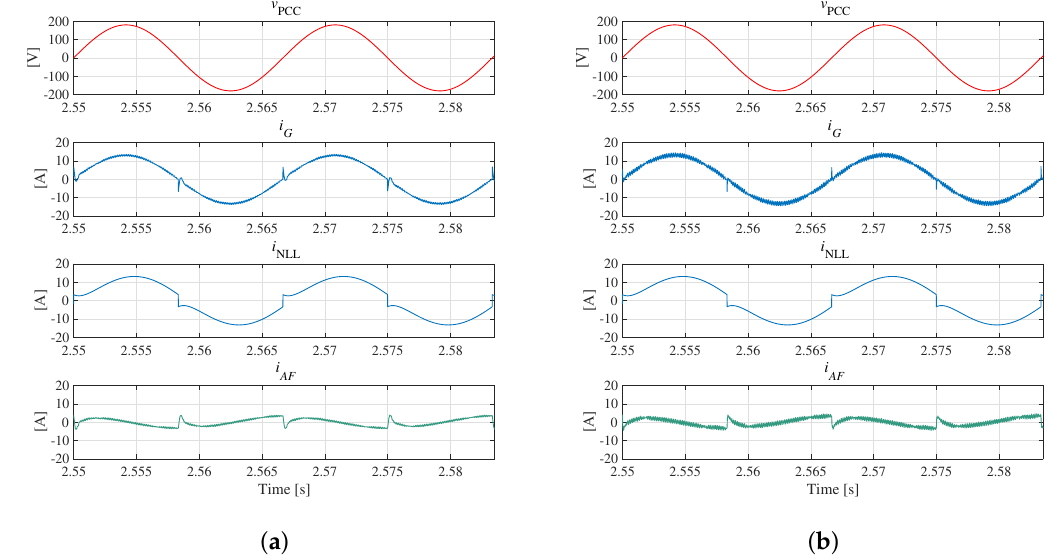
Figure 10. Steady state responses of the voltage at the PCC v PCC , the compensated line current i G , the current consumed by the NLL i NLL with RLload, and the injected current i AF with the inductive output filter of ( a ) L F = 3 mH and ( b ) L F = 1